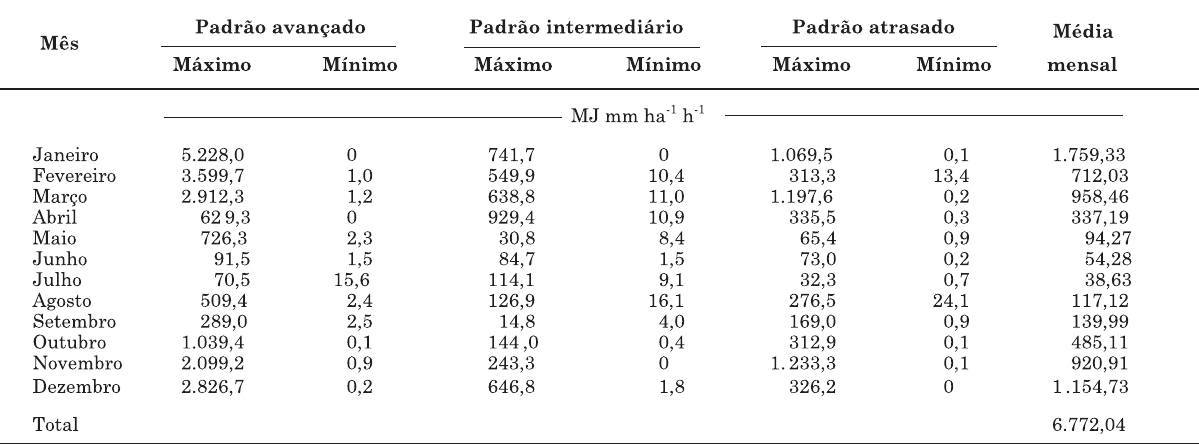
Figura 1. Distribuição mensal do EI (b) em Ribeirão das Lajes (RJ), em função dos padrões de